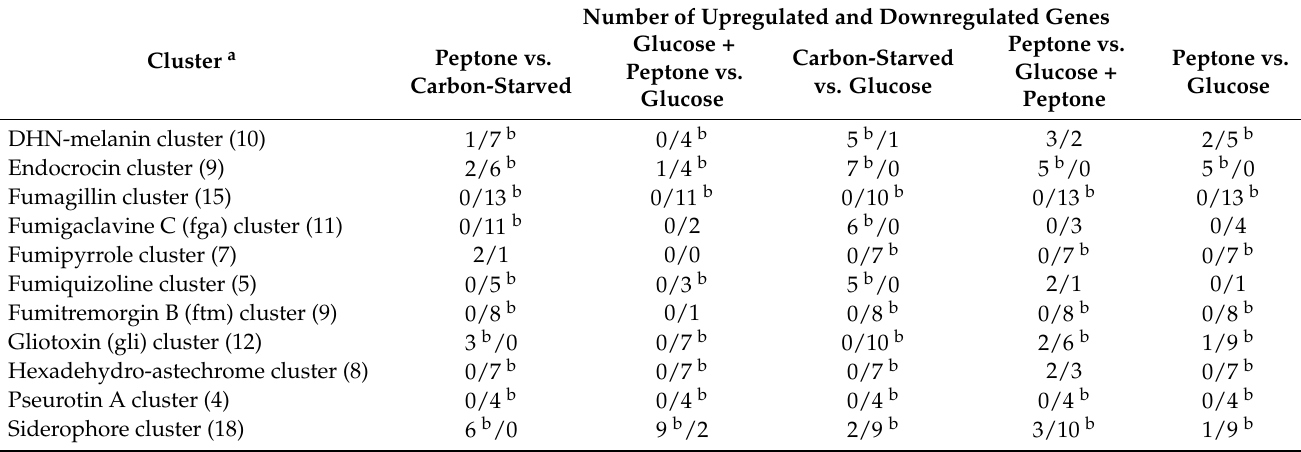
Table 5. Transcriptional behavior of selected secondary metabolite cluster genes in carbon-stressed A. fumigatus